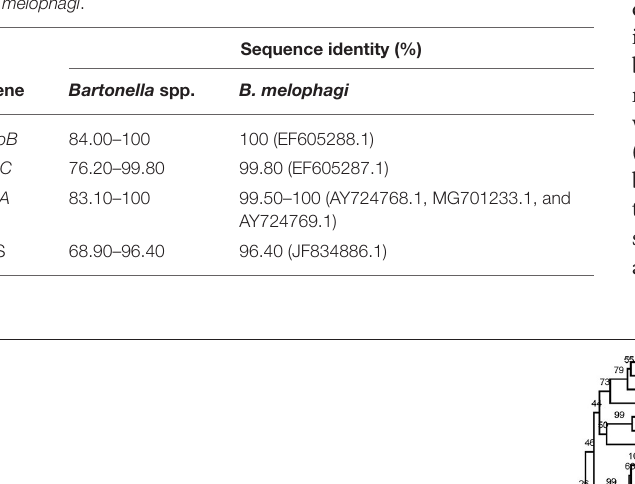
Frontiers in Veterinary Science |